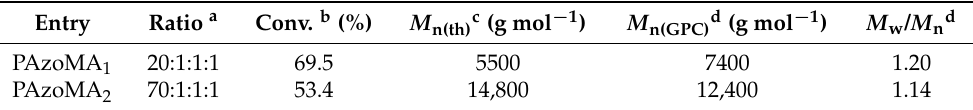
Table 1. Molecular weight characteristics of the Azo-containing